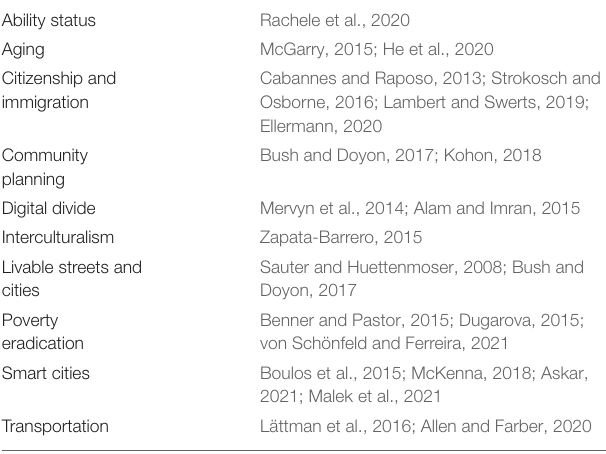
TABLE 1 | Recent studies of urban social